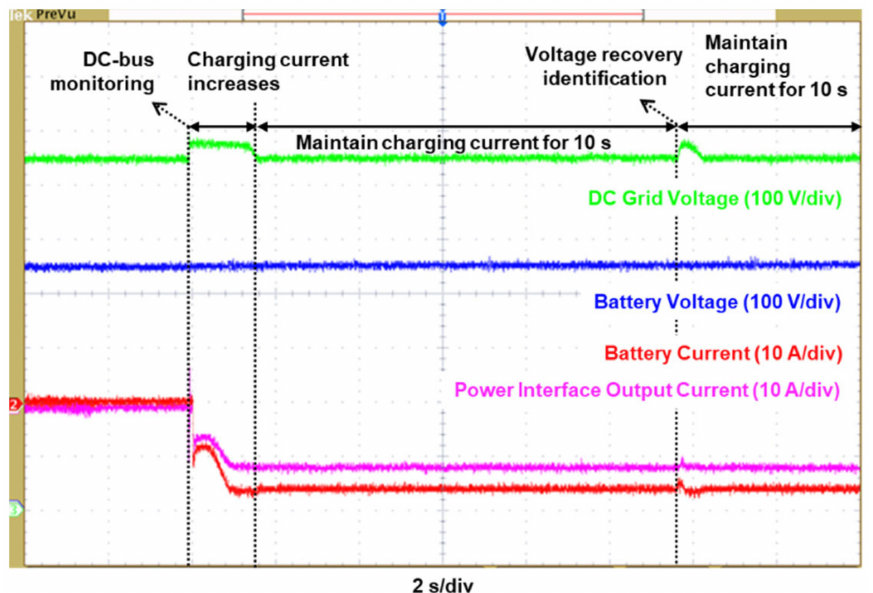
Figure 17. Experimental results of proposed voltage regulation algorithm at overvoltage condition.